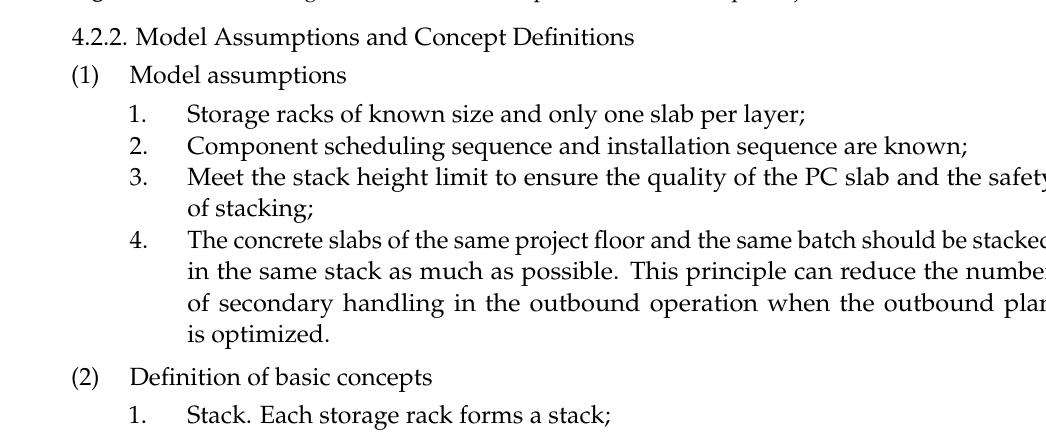
Figure 4. Schematic diagram of the number of palletization and flap readjustment.